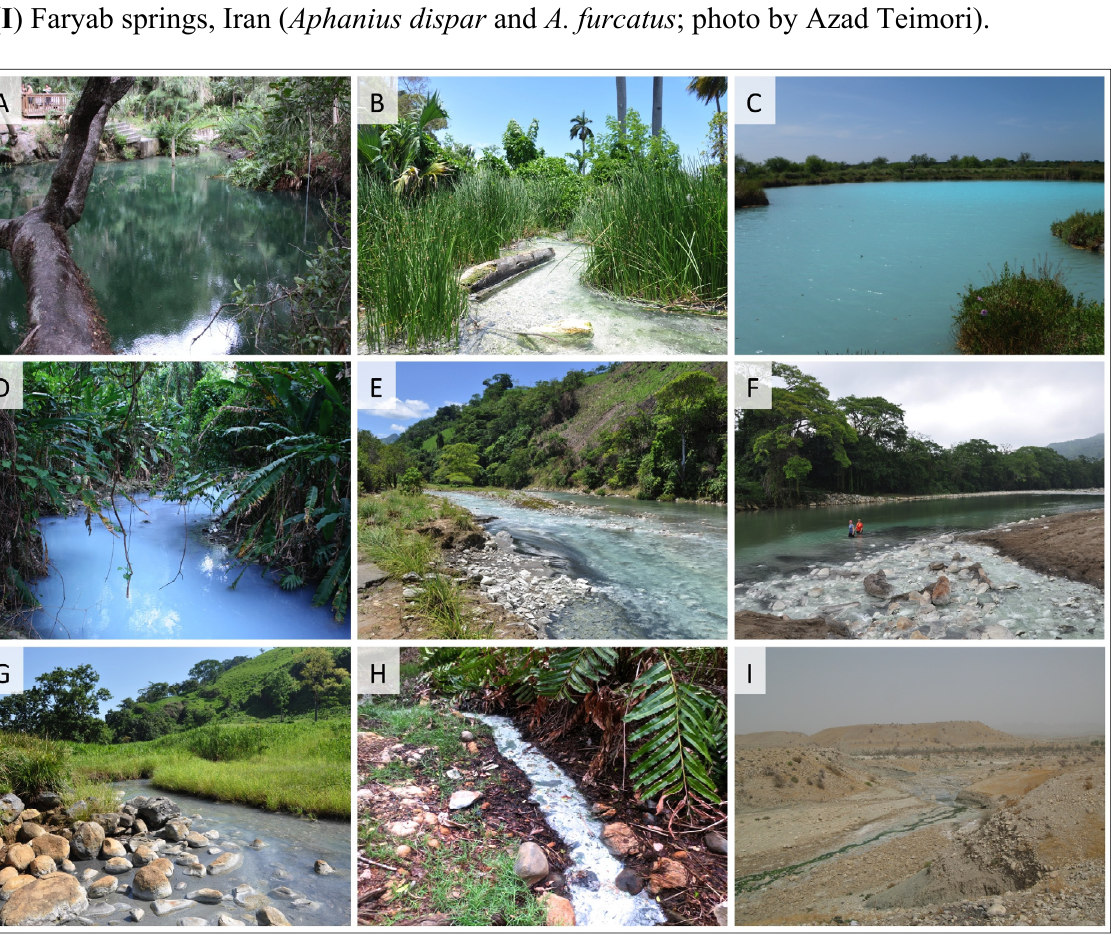
Figure 2. Examples of the diversity of sulphide springs inhabited by fishes. ( A ) Green Springs, Florida (inhabited by Gambusia holbrooki ; photo by Rüdiger Riesch); ( B ) La Zurza spring, Dominican Republic ( Limia sulphurophila ); ( C ) Baños de San Ignacio, Mexico ( Cyprinodon bobmilleri , Poecilia mexicana limantouri , and P. formosa ; photo by Ingo Schlupp); ( D ) El Azufre II, Mexico (sulphidic ecotype of P. mexicana mexicana and Ophisternon aenigmaticum ); ( E ) Puyacatengo springs, Mexico (sulphidic ecotype of P. m. mexicana ); ( F ) La Esperanza (big) springs, Mexico ( P. thermalis ); ( G ) La Gloria springs, Mexico ( P. sulphuraria, Pseudoxiphophorus bimaculata, Xiphophorus hellerii , and Ophisternon aenigmaticum ); ( H ) a sulphide spring near David, Panama ( Brachyraphis roseni , Poeciliopsis elongata , and Priapichthys panamensis ; photo by Spencer Ingley); and ( I ) Faryab springs, Iran ( Aphanius dispar and A. furcatus ; photo by Azad